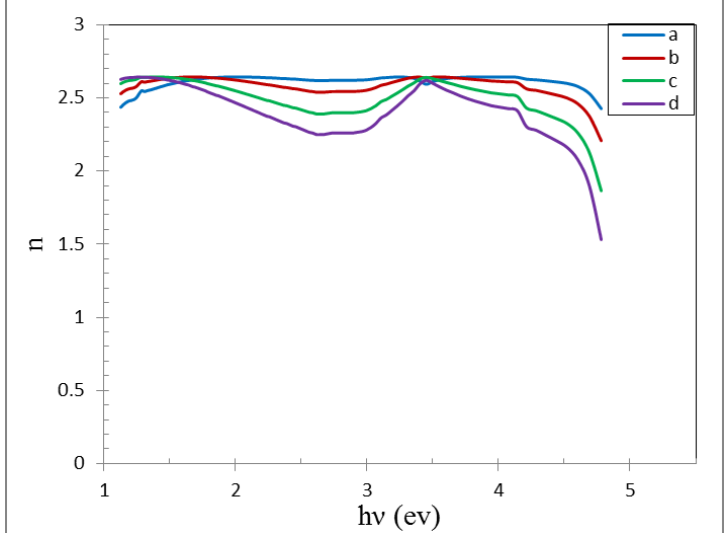
Fig.4: The refractive index as a function of photon energy incident on glass for different doping concentrations of graphene oxide thin films ((a) 2%, (b) 4%, (c) 6% and (d) 8%